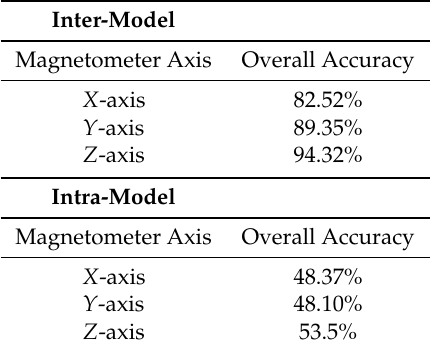
Table 7. Average overall accuracy for inter-model and intra-model classification.